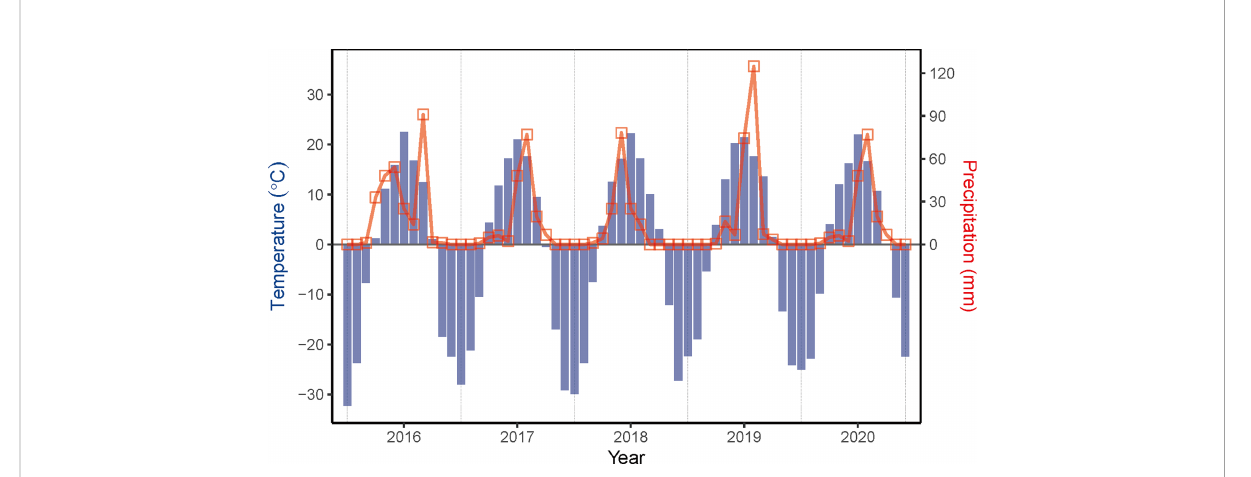
FIGURE 2 Variations in monthly temperature and precipitation measured on-site from 2016 to 2020.